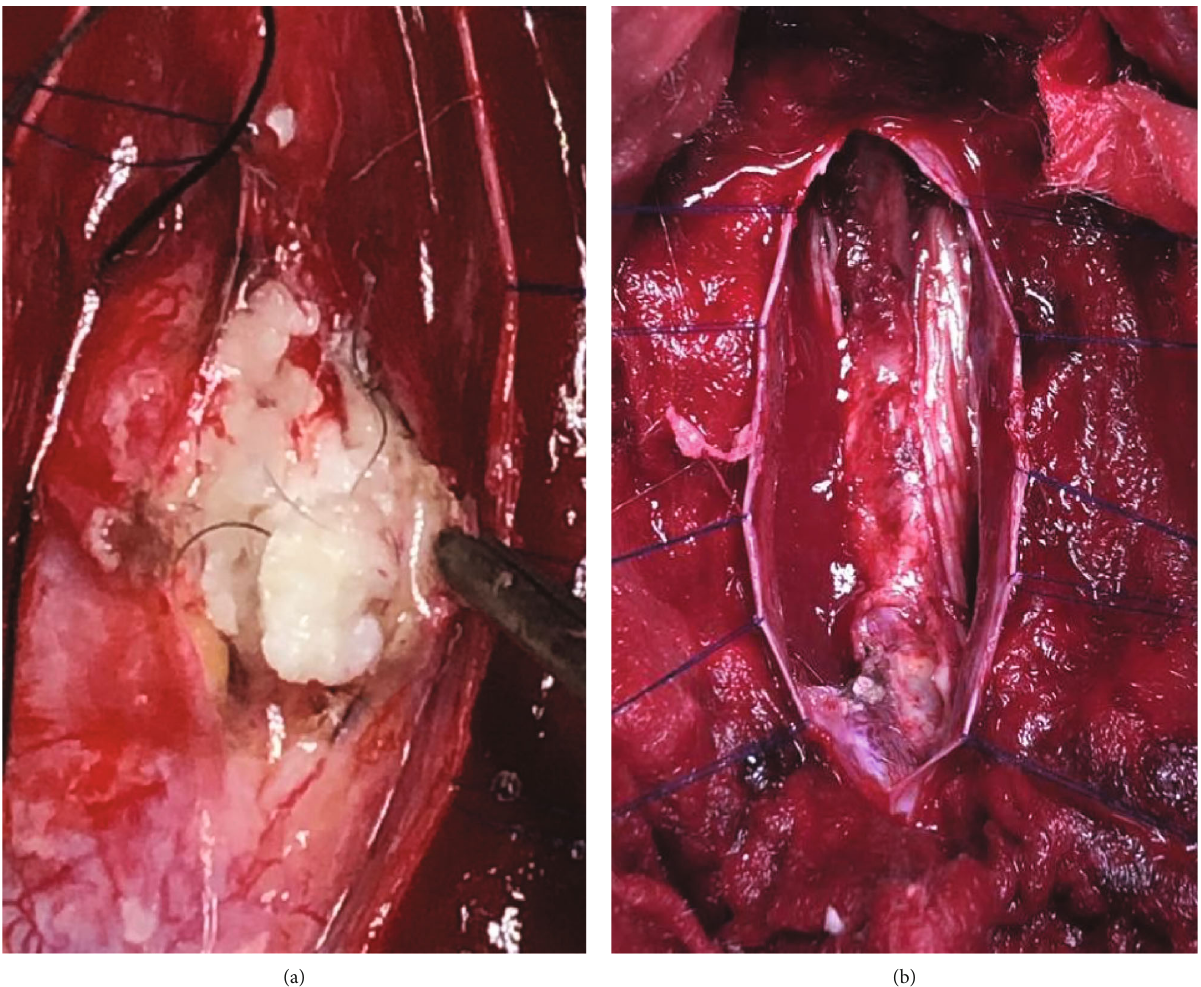
Figure 3: (a) Soft pearly white amorphous tissue along with hair follicles was found after the tumor was incised. (b) After subtotal excision of the tumor while preserving neurological tissues as much as